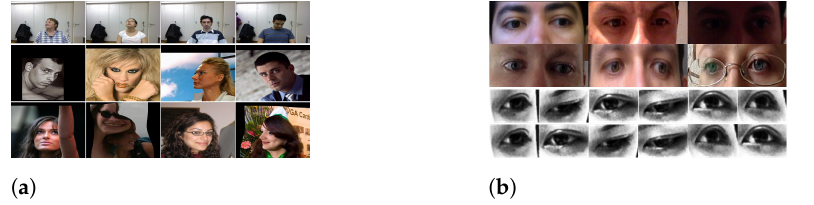
Figure 4. ( a ) Images from the head pose datasets: BIWI (first row), AFLW2000 (second row), and 300W-LP (third row); ( b ) images from the gaze datasets: MPIIGaze (top) and UT-Multiview